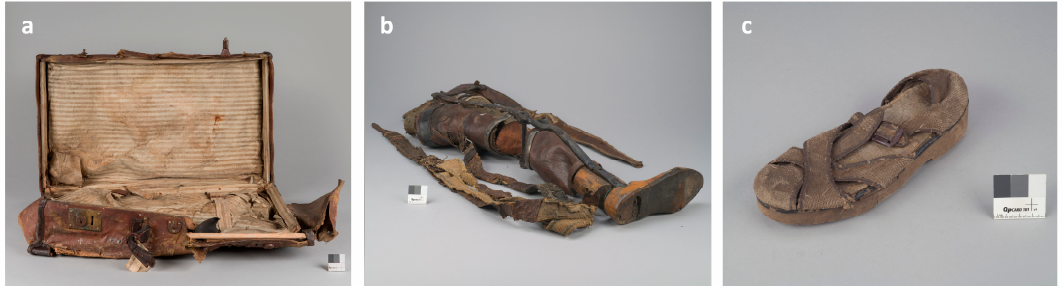
Figure 1. T extile objects from Auschwi tz -Birkenau State Museum: ( a ) suitcase; ( b ) prosthesis; ( c ) Figure 1. Textile objects from Auschwitz-Birkenau State Museum: ( a ) suitcase; ( b ) prosthesis; ( c ) shoe shoe (sources: ( a ) Adam de Sas Topolnicki, ( b ) Sebastian Mrozek, ( c ) Jerzy Besty ń ski). (sources: ( a ) Adam de Sas Topolnicki, ( b ) Sebastian Mrozek, ( c ) Jerzy